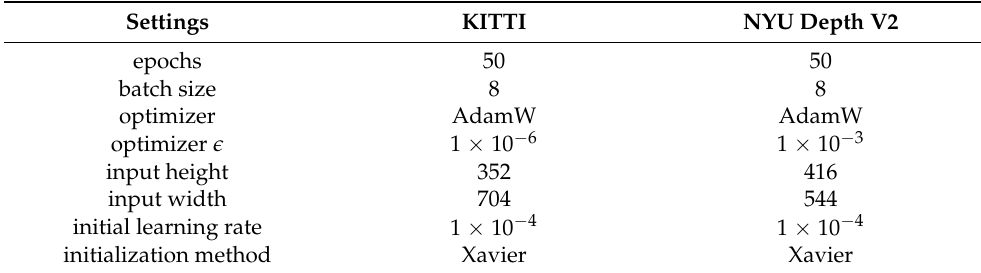
Table 1. Training settings on two